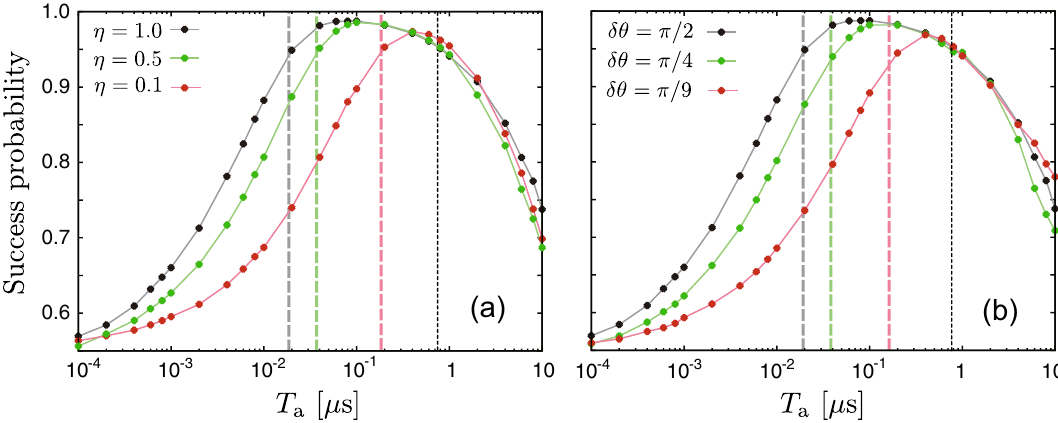
π/ 2 ; Figure 8. Dependence of the success probability on T a for various values of η and δθ . Panel ( a ) is for δθ = 1 . The other parameters are the same as in Fig. 2. In panel ( a ), the vertical gray, green and panel ( b ) is for η = 10 − 2 and 1.86 1.86 10 − 2 , 3.73 10 − 1 µ s , respectively; in panel ( b ), red dashed lines represent T L 0.95 × = × × 10 − 2 and 1.59 1.86 10 − 2 , 3.73 10 − 1 µ s , the vertical gray, green and red dashed lines represent T L 0.95 × = × × 7.52 10 − 1 µ s in both respectively. The vertical black dotted line is for T U 0.95 = ×